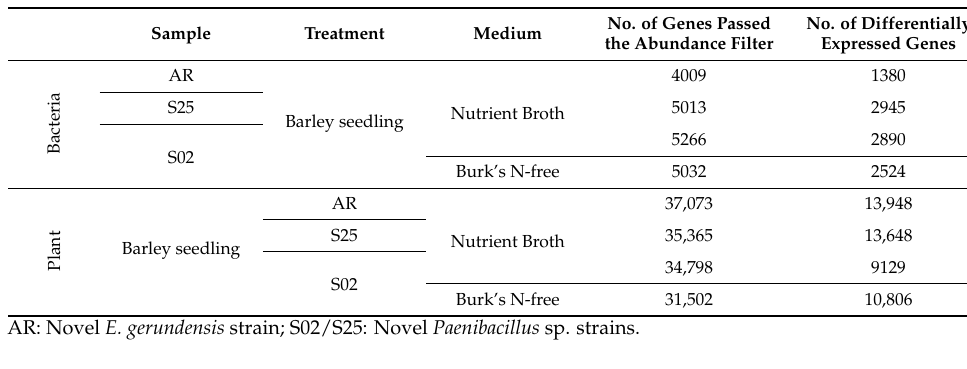
Table 1. Bacterial and plant genes that passed the abundance filter and were differentially expressed identified by DGE analyses.